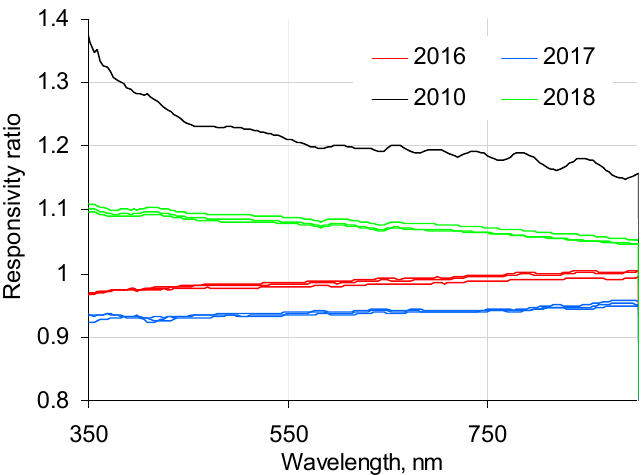
Figure 11. Relative change of responsivity of the SAM 8329. Year of the radiometric calibration is shown with color: 2010 black, 2016 red, 2017, blue, 2018 green.